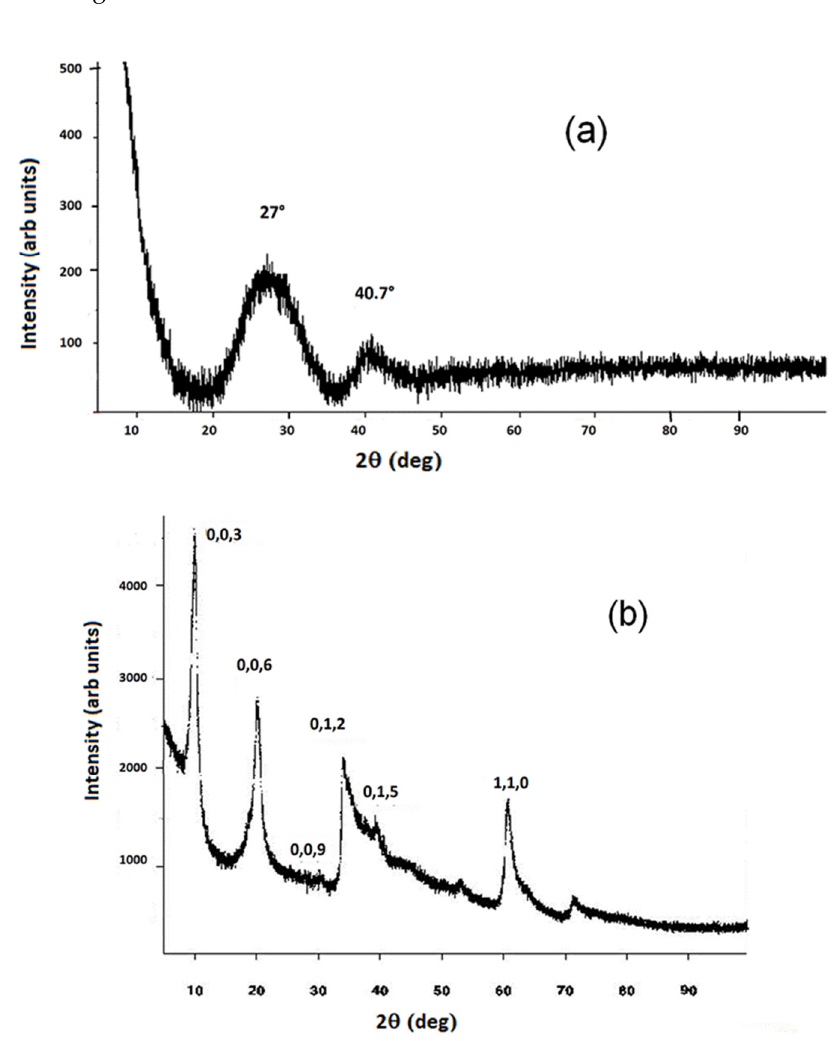
Figure 1. XRD patterns pertaining to allophane ( a ) and to ZnAl-SO 4 LDH ( b ).